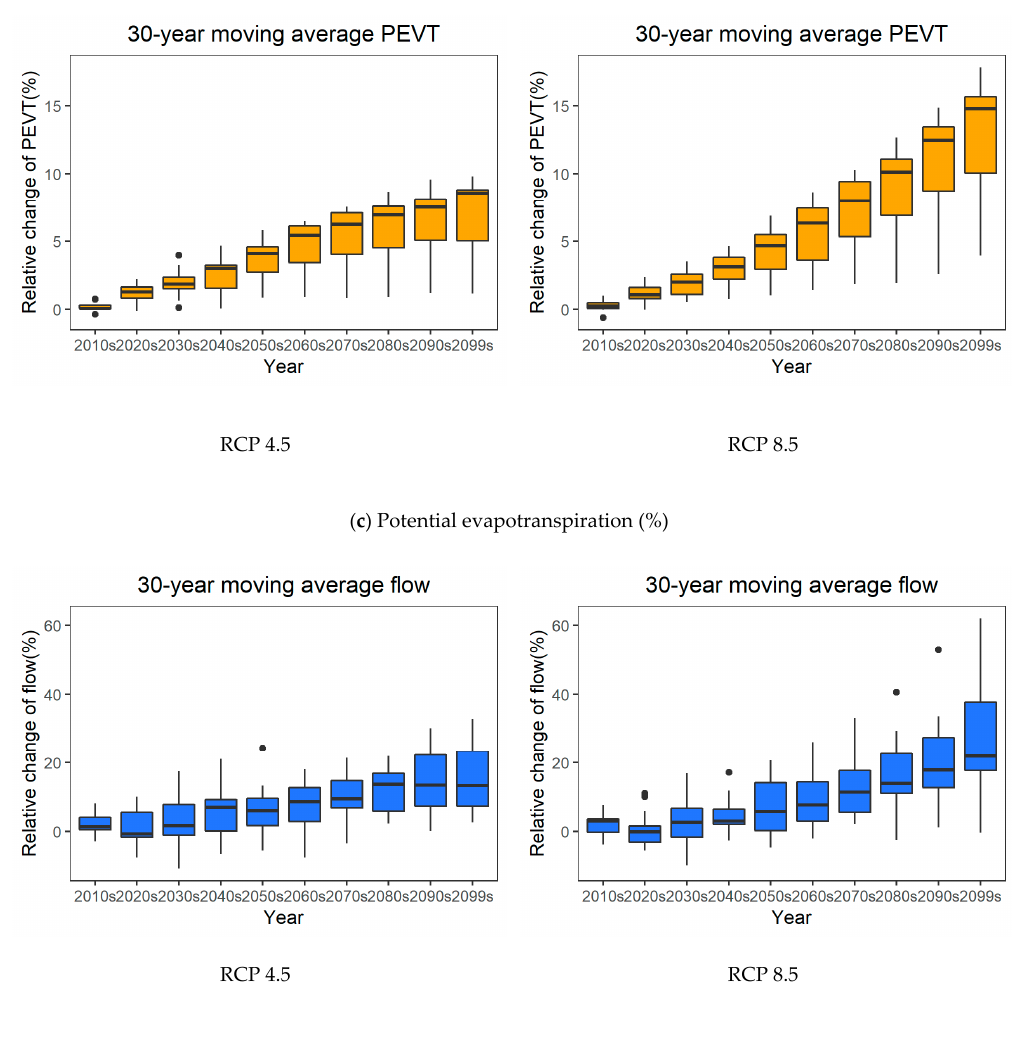
Figure 5. Relative change (%, °C) of the 30-year moving average annual precipitation, temperature, potential evapotranspiration, and flow compared with the reference period (1976–2005) for RCP scenarios 4.5 and 8.5 using 13 GCM in South Korea. PEVT denotes the potential evapotranspiration. Values were calculated by first converting the daily flow data into annual flow data. Next, the relative change of 30-year moving average for 13 GCMs was calculated and is shown as a box plot.